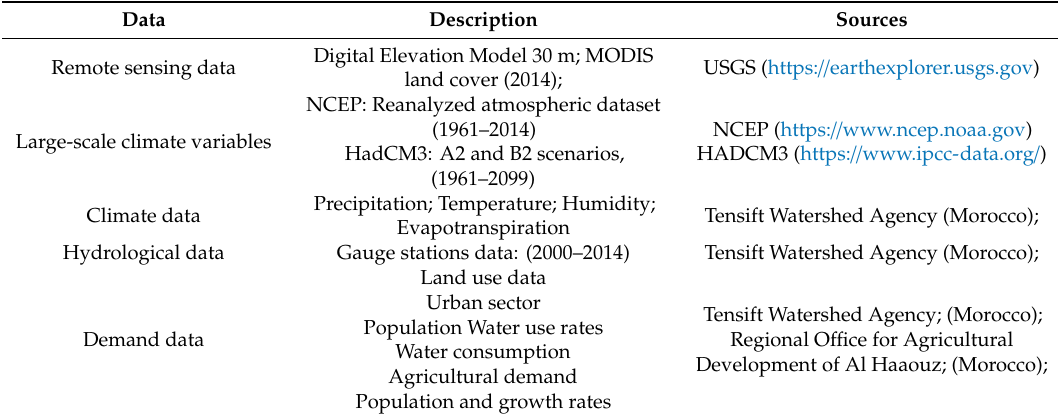
Table 1. Sources and information of the used